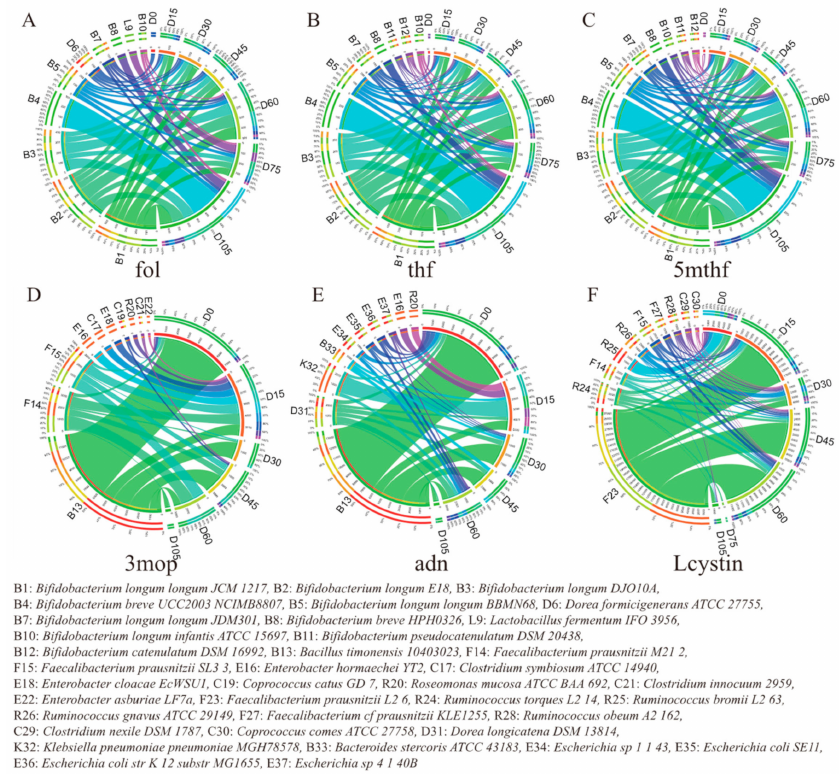
Figure 2. The contribution of strains to metabolites ( A ) fol ( B ) thf ( C ) 5mthf ( D ) 3mop ( E ) adn, and ( F ) Lcystin at different dietary intervention timepoints. Each circle represents a metabolite with its top 10 contributing strains (left part of the circle). The right part of each circle represents the 7 different